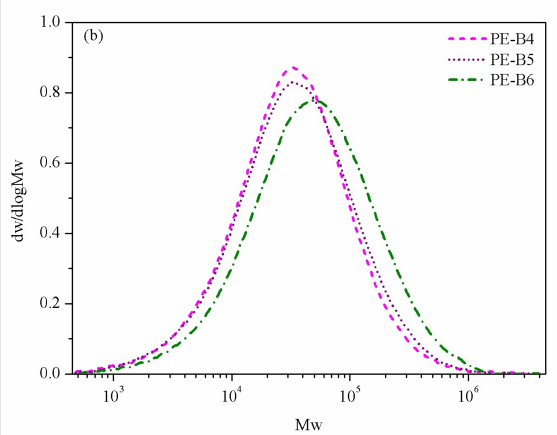
Figure 1. Molecular weight and Molecular weight distribution of samples ( a ) PE-B1, PE-B2, PE-B3,